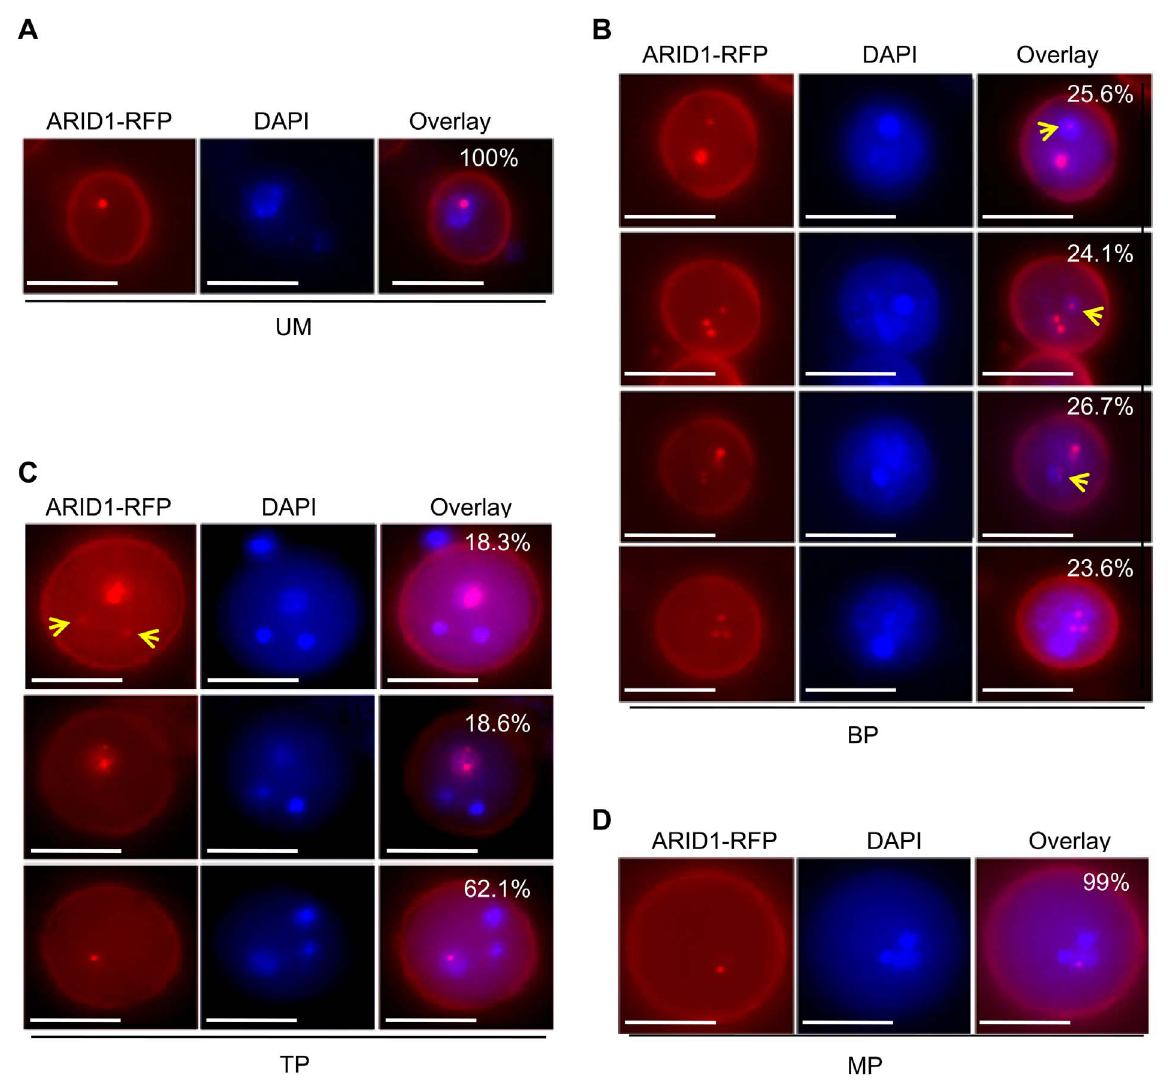
Figure 4. ARID1 localization is developmentally dynamic during sperm cell formation. Representative images of unicellular microspores (UM) (A), bicellular pollen (BP) (B), tricellular pollen (TP) (C), and mature pollen (MP) (D) from ARID1-RFP transgenic plants. Yellow arrows indicate RFP signals in the generative nuclei and sperm cells. The percentages indicate incidence of each pattern. 600–800 pollen grains were analyzed for each stage. Scale bar, 10 m m.